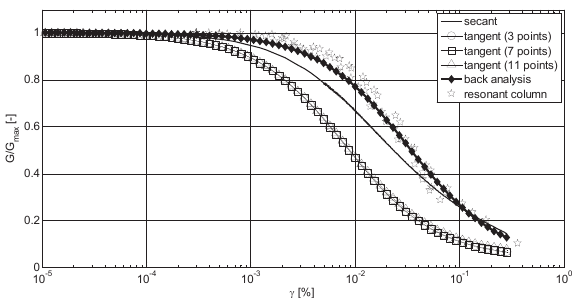
Fig. 12. Exemplary results of back analysis of sample S3057. Fig. 13. The results of RC/TS analyses of the sample S3057. Figure 13: The results of RC/TS analyses of the sample S3057.